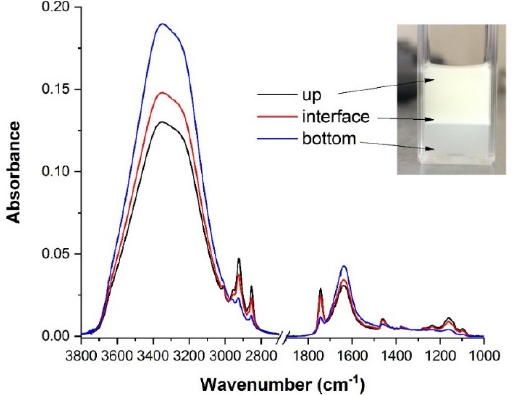
Figure 6. Evidence of emulsion creaming through FTIR spectra.